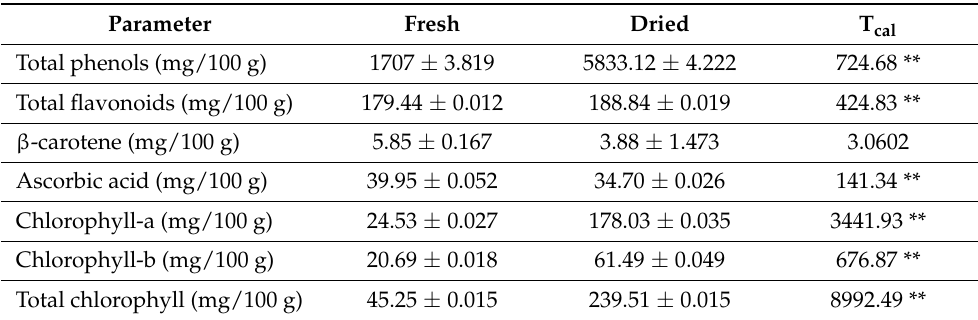
Table 3. Comparative analysis of bioactive constituents of T. officinale leaves.